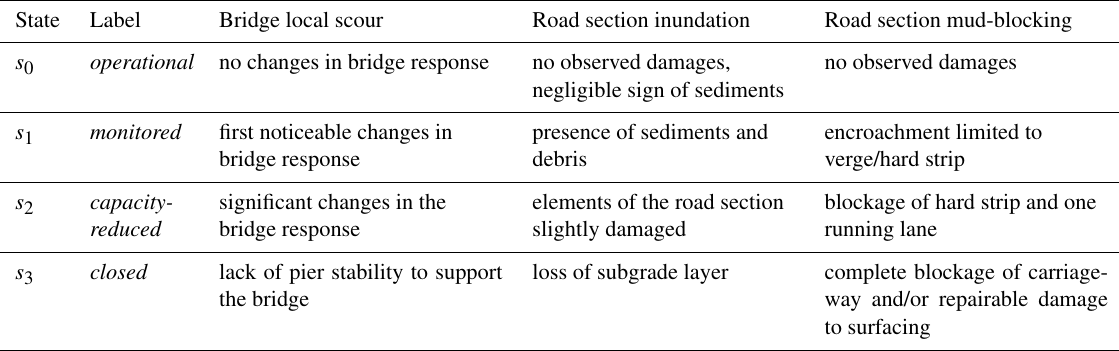
Table 1. Damage states for bridge local scour, road section inundation and road section mud-blocking. State